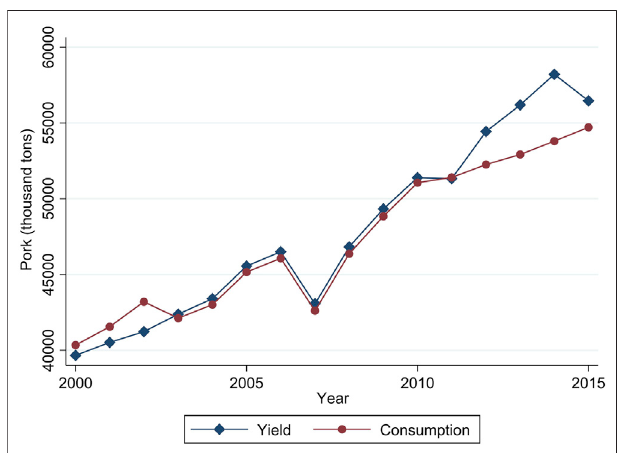
FIGURE 1 | China ’ s pork production and consumption from 2000 to